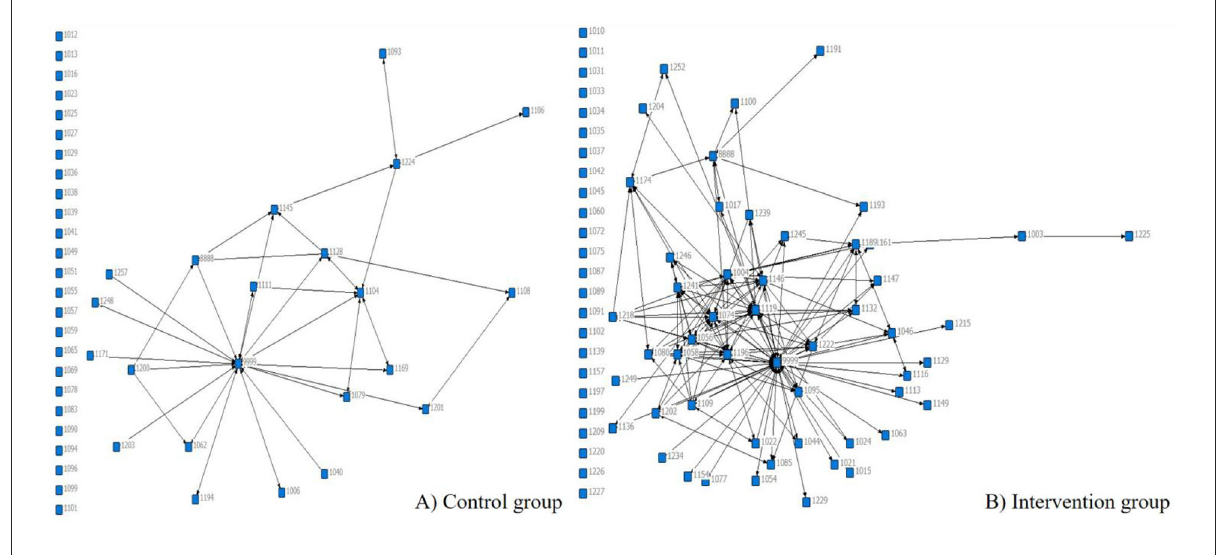
FIGURE3 The social network of intervention group and control